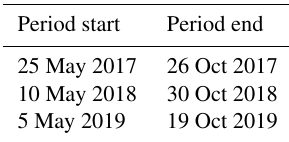
Table 4. Estimated ice-free period start and end dates for the studied